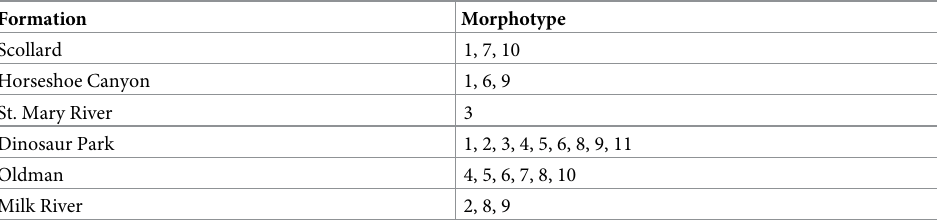
Table 1. Stratigraphic distribution of